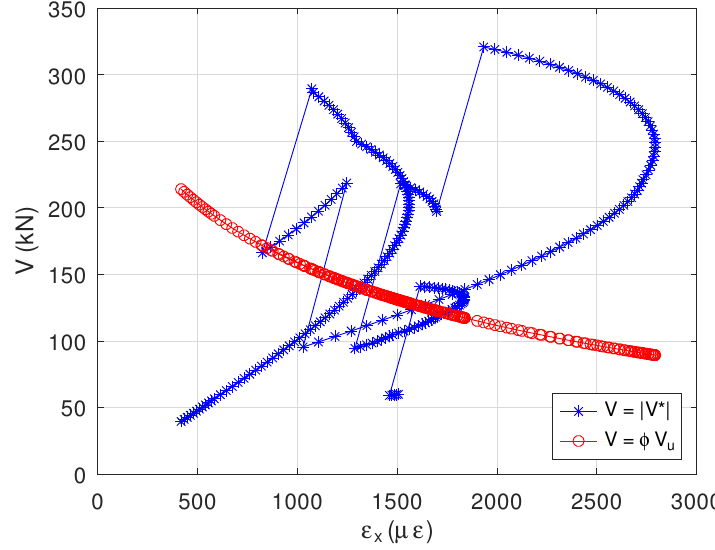
Figure 10. V ∗ versus (cid:101) x for x veh = 10.0 to 34.5 m in steps of 0.1 m. Load rating factors for shear were calculated using the load effects directly without the use of iterations at every step of movement, and they are shown in the plot of load rating factor versus x veh in Figure 11 for the vehicle-bridge system for the continuous beam. Only factors between zero and 0.8 are shown in the plot. The lowest rating factor is 0.23 when x veh is 18.0 m. It did not occur at the end of the shear discontinuity when the third axle crossed the critical section at x veh = 16.5 m. It occurs at maximum absolute moment with decreasing shear after the axle moves away from the